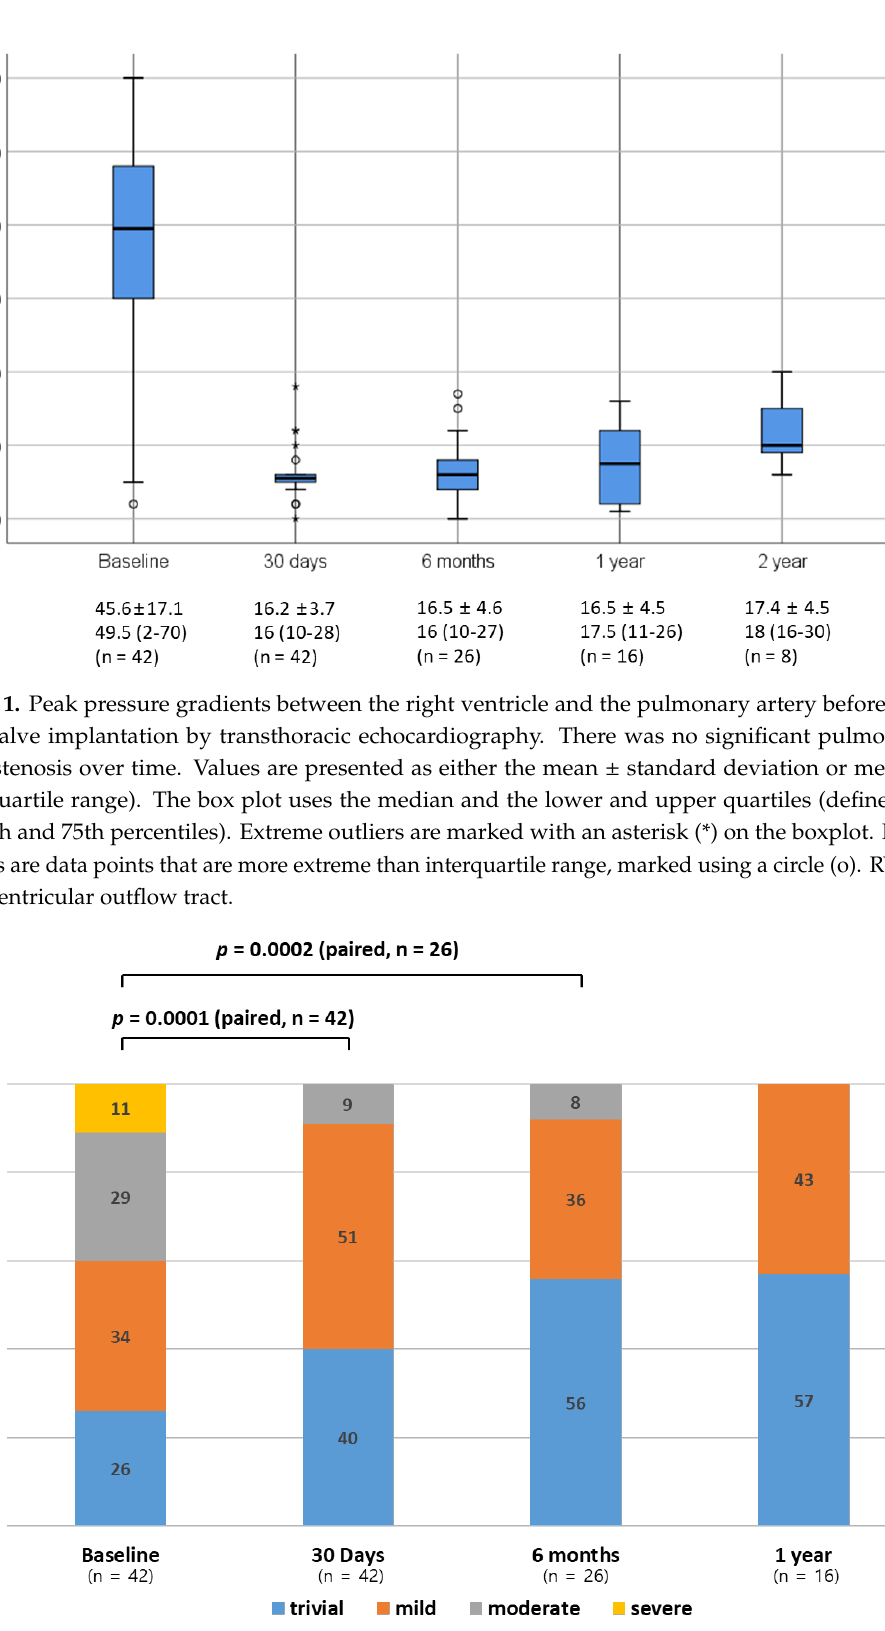
Figure 2. Changes in tricuspid valve regurgitation over time: before and after pulmonary valve implantation, as seen on transthoracic echocardiography. The proportion of greater than moderate tricuspid valve regurgitation decreased after pulmonary valve implantation.